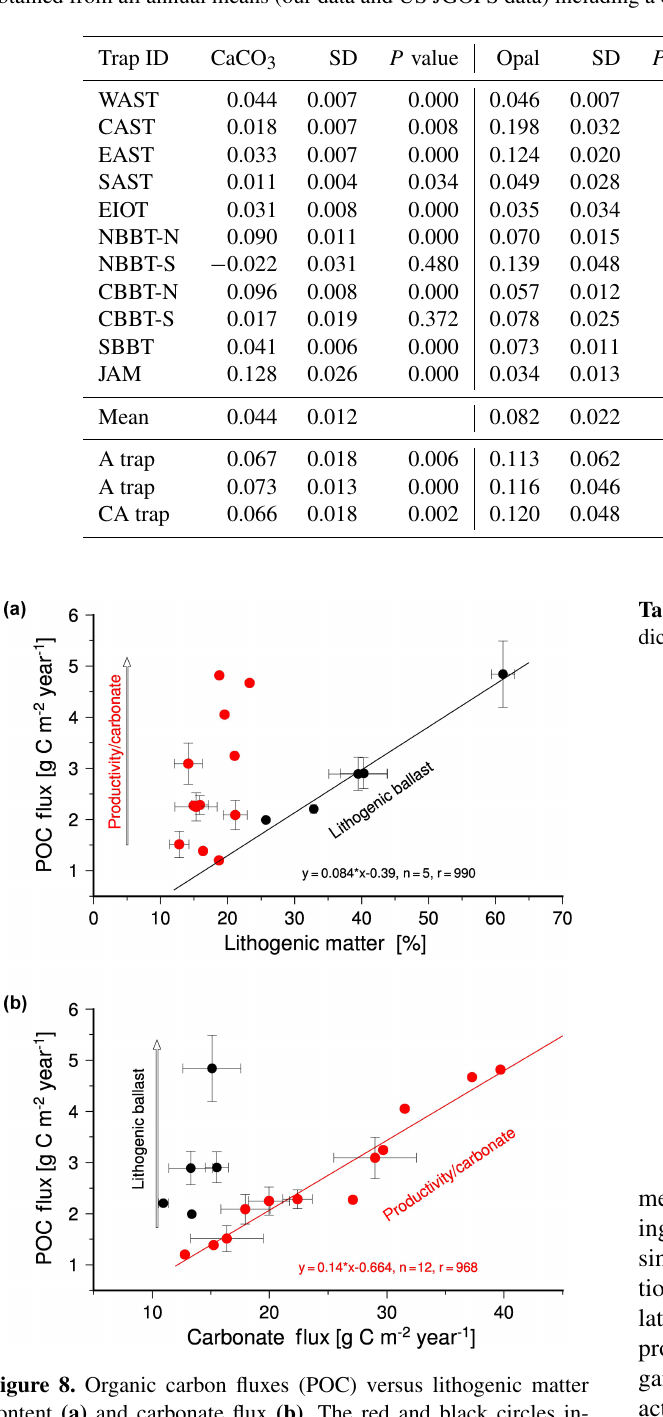
Table 7. Carrying coefficients derived from the MLR applied to data measured at the trap sites (trap ID) including the mean. “No.” indicates the number of data used for the analysis. The A trap shows the carrying coefficients derived by applying the MLR to the annual mean sediment data obtained from our sites (no. = 11) and including the US JGOFS data (no. = 17). The CA trap shows carrying coefficients obtained from all annual means (our data and US JGOFS data) including a constant term from Eq. (4).